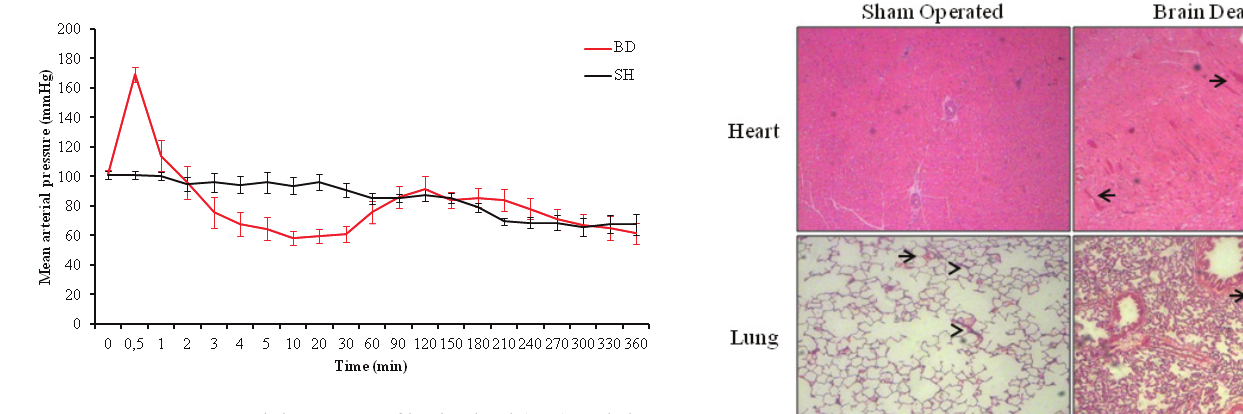
FIGURE 1 - Mean arterial pressure of brain-dead (BD) and sham- operated (SH) rats 360 min after surgical procedures. The animals were monitored over time. The data are presented as the mean ± SEM.